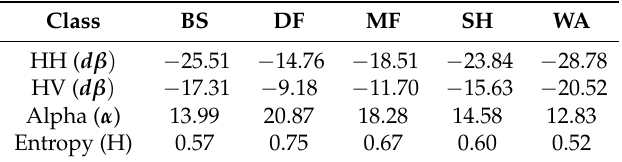
Figure 6. ( a,b ) Cloude-Pottier decomposition of the training samples of the selected land cover classes (Table 1). Z 1 , Z 4 and Z 7 are characterized by double bounce scattering, Z 3 , Z 6 and Z 9 by surface scattering, and Z 2 , Z 5 and Z 8 by volume scattering. The black dashed polygon indicates the extent of Figure 5b; a zoomed view of the training samples distribution on the Alpha-Entropy plane. Table 5. Extracted mean values of ALOS PALSAR backscattering (HH, HV), alpha and entropy based on the training samples for the selected land cover classes (Table 1).